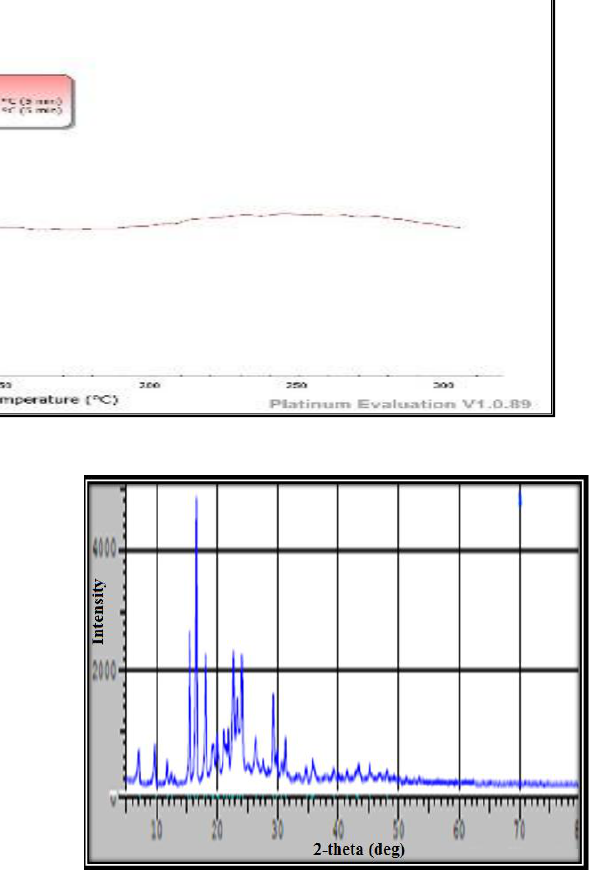
Figure14. X-ray diffraction pattern of